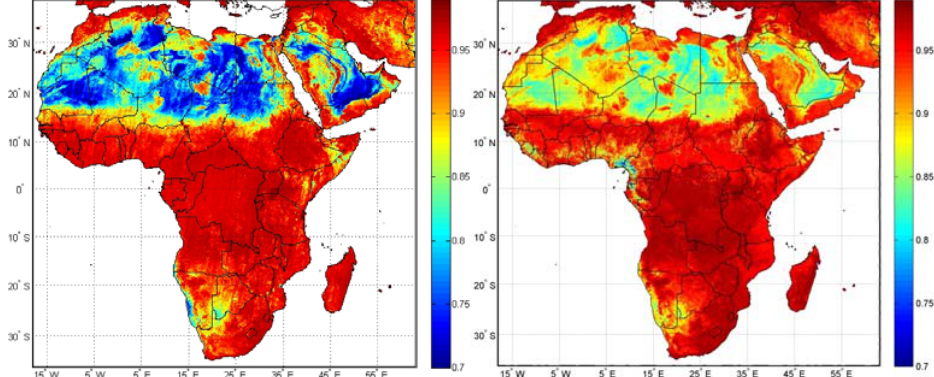
Figure 1. ( Left ) Advanced Spaceborne Thermal Emission and Reflection Radiometer Global Emissivity Dataset (ASTER GEDv3) mean summertime (July–September) emissivity for band 12 (9.1 µm), ( Right ) UW-Madison MODIS Infrared emissivity dataset Baseline Fit emissivity (UW BF) mean summertime (July–September) emissivity at 9.1 µm, which is the same as Moderate Resolution Imaging Spectroradiometer (MODIS) Band 29, 8.5 µm.